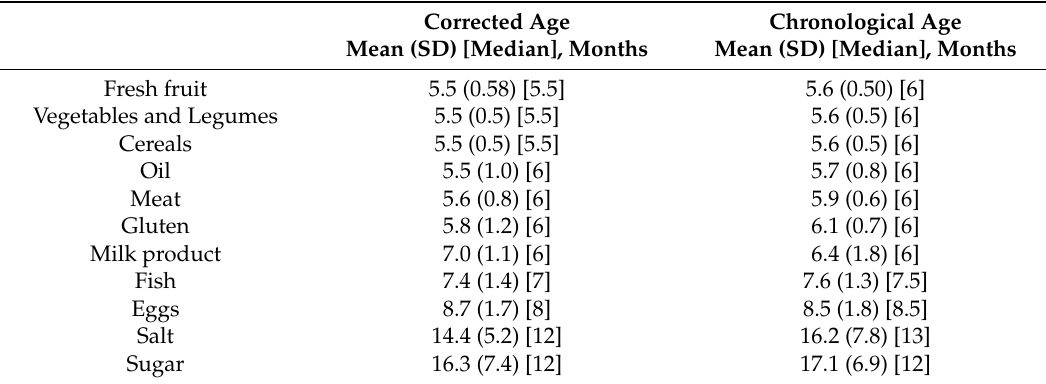
Table 1. Timing of introduction of the single food groups in months.